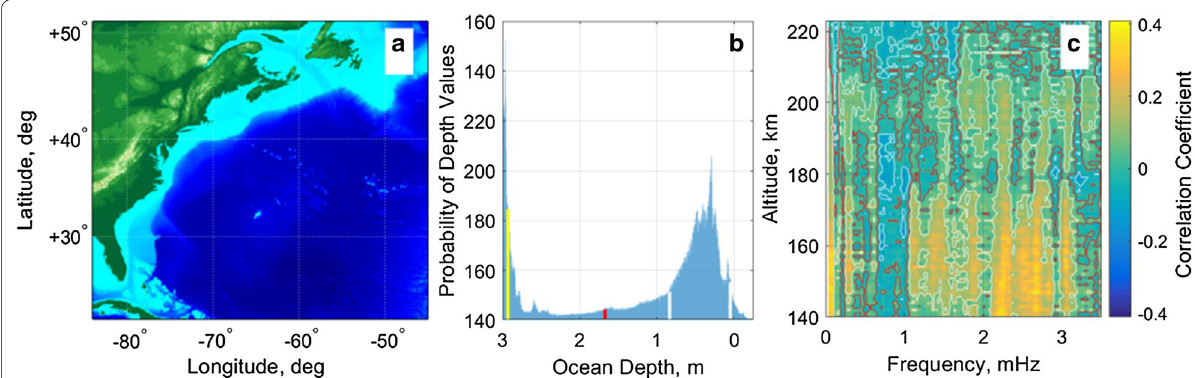
Fig. 8 Bathymetry of northwest Atlantic and correlation of the oceanic and atmospheric wave activity observed in the area. a Bathymetry map of northwest Atlantic. b Probability density function of water depths in the part of the Atlantic Ocean depicted in a . Depth distribution is calculated in the area from 20° to 50° N and from 40° to 80° W using the satellite altimetry-derived global 2-min bathymetry dataset (Smith and Sandwell 1997) provided in MATLAB. The four water depths indicated by color, 150 m (yellow), 2649 m (red), 4300 m and 5900 m (white), are the depth for which the infragravity wave dispersion curves are shown in Fig. 5. c Correlation coefficient of spectral amplitudes of the wave activities observed in the Atlantic Ocean at the location of NDBC Station 44402 (39.30 °N 70.66 °W) and in the thermosphere over the Wallops Island, Virginia ( c is adapted from (Zabotin et al.